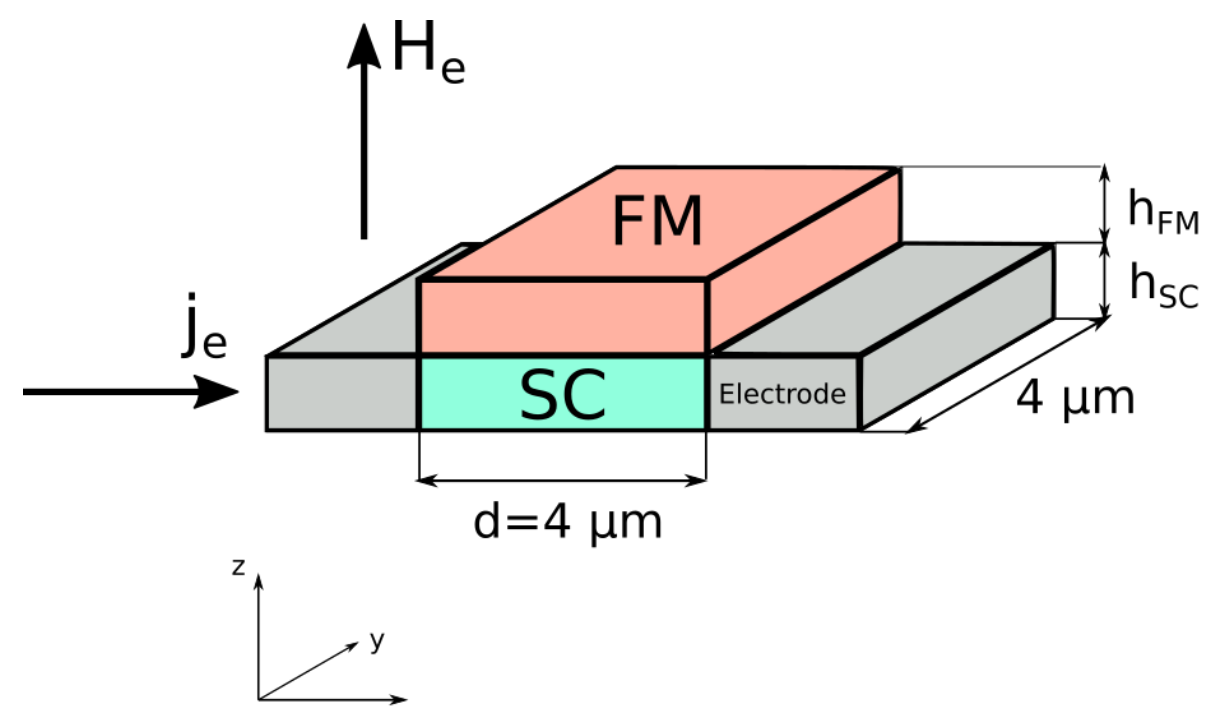
Figure 1. Schematic of the system. A superconducting square film of length d and height h SC placed underneath a square non-superconducting film of height h FM that hosts a helical spin order with a spin-driven ferroelectricity, meaning we are dealing with a multiferroic (MF) layer. The bilayer is subject to an external magnetic field H e = H e e z , and the external current j e = j e e x flows in the superconductor